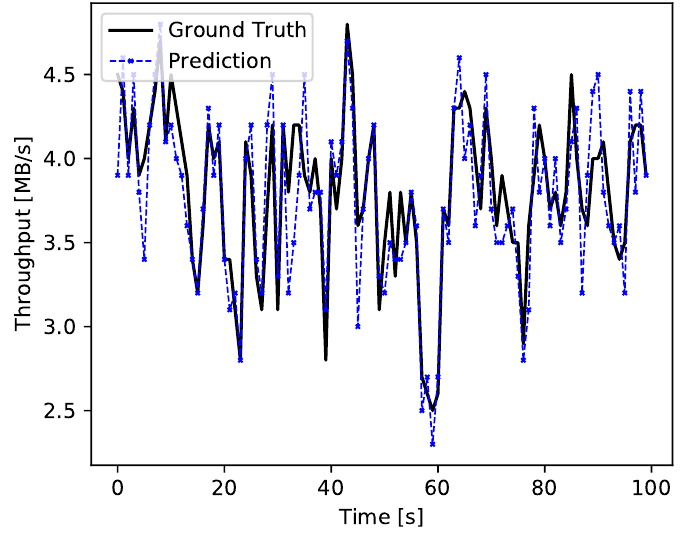
Figure 8. One-step prediction for the M5G trace. The prediction tends to overestimate the traffic oscillations, but the unidirectional LSTM ANN achieves better results than a naive predictor based on a simple moving average.